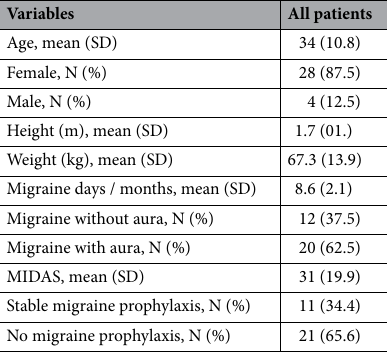
Table 1. Summary statistics of patient characteristics. Categorical variables are summarized as frequencies and percentages (%), numerical variables are summarized by mean and one standard deviation (sd). SD = standard deviation, m = meter, kg =